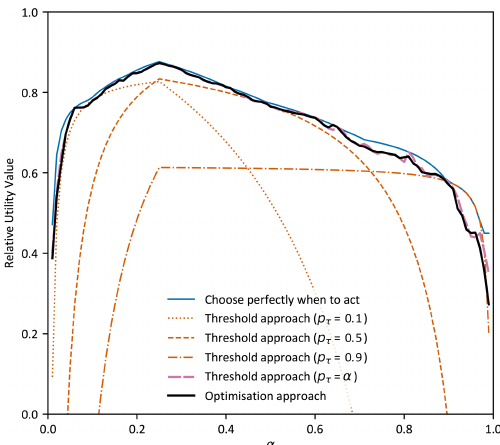
Figure 5. Forecast value quantified using four different approaches to decision-making: the optimisation approach and the threshold ap- proach with either perfect critical probability thresholds, specific critical thresholds, or the critical threshold set equal to the α value. A binary decision of flow exceeding the top 25% of observations was used, with subseasonal forecasts from the first week of lead times and a risk-neutral user. Specific critical thresholds are the 0.1, 0.5, and 0.9 forecast quantile corresponding to acting when there is a high or low chance of the event occurring,